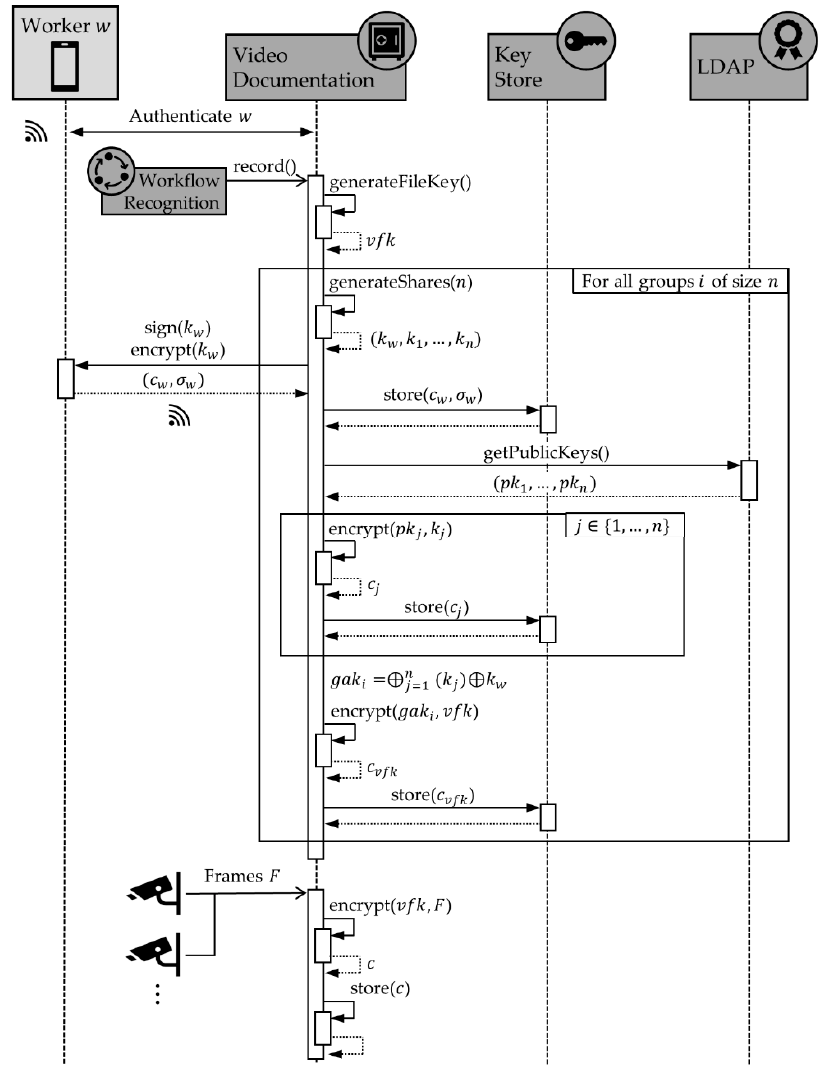
Figure 5. 4Crypt video encryption process.